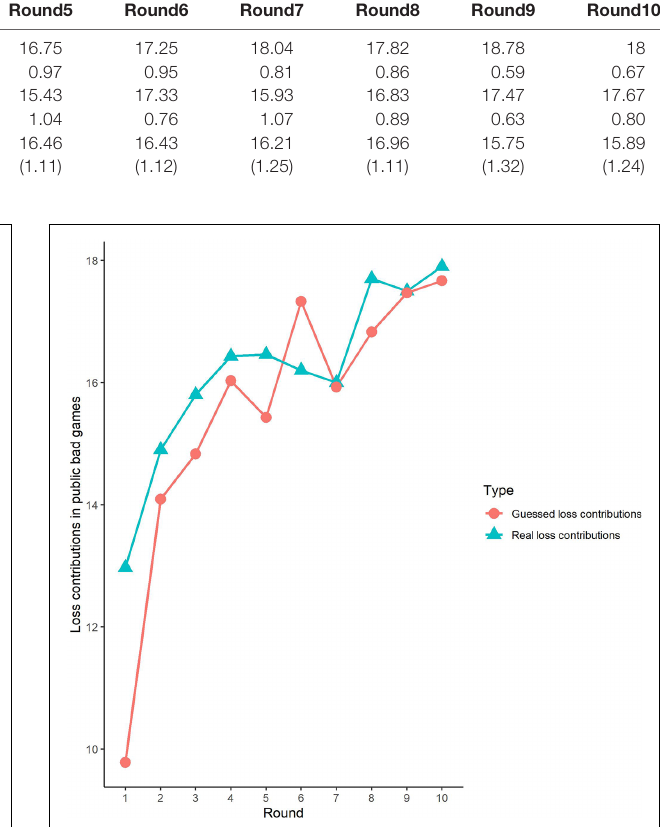
TABLE 4 | Means and SE of the data for estimated loss contributions in public bad games under three conditions. Stimulation